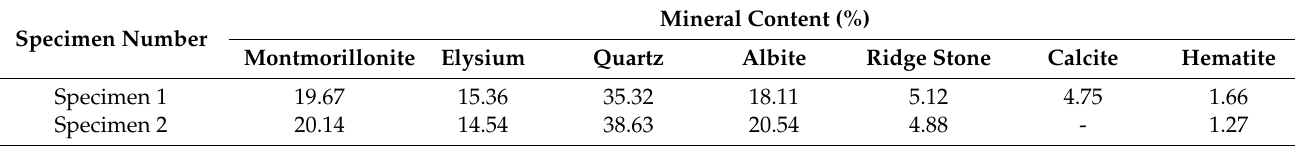
Table 1. The XRD results of